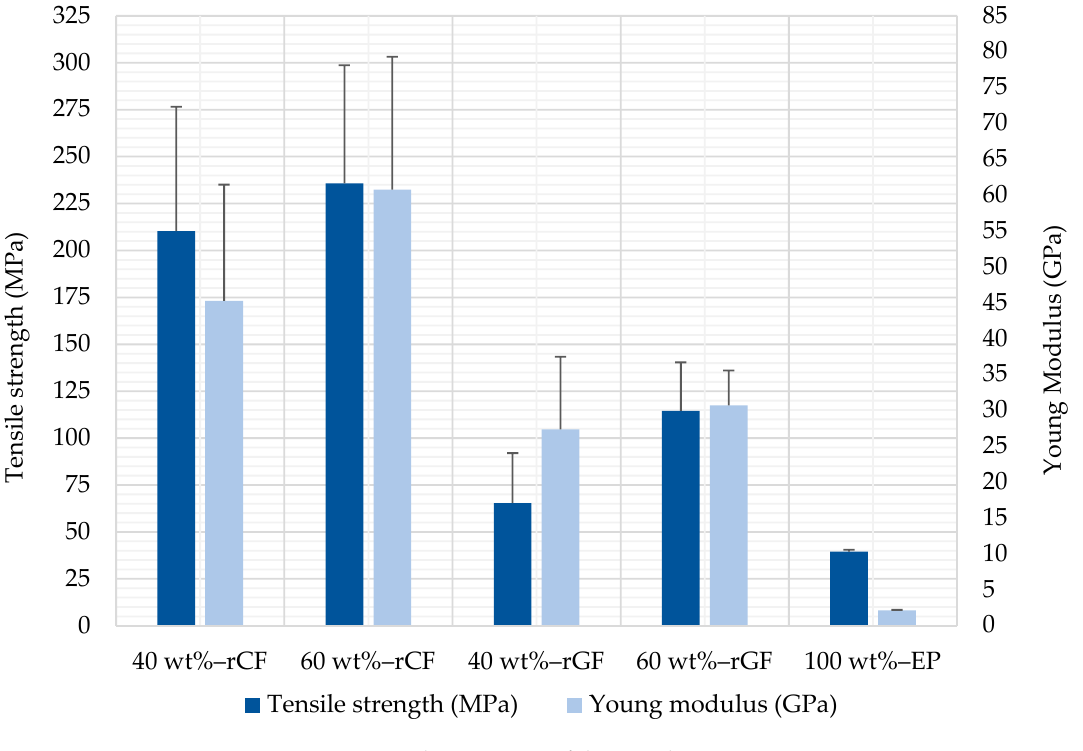
Figure 8. Tensile properties of the tested composites.